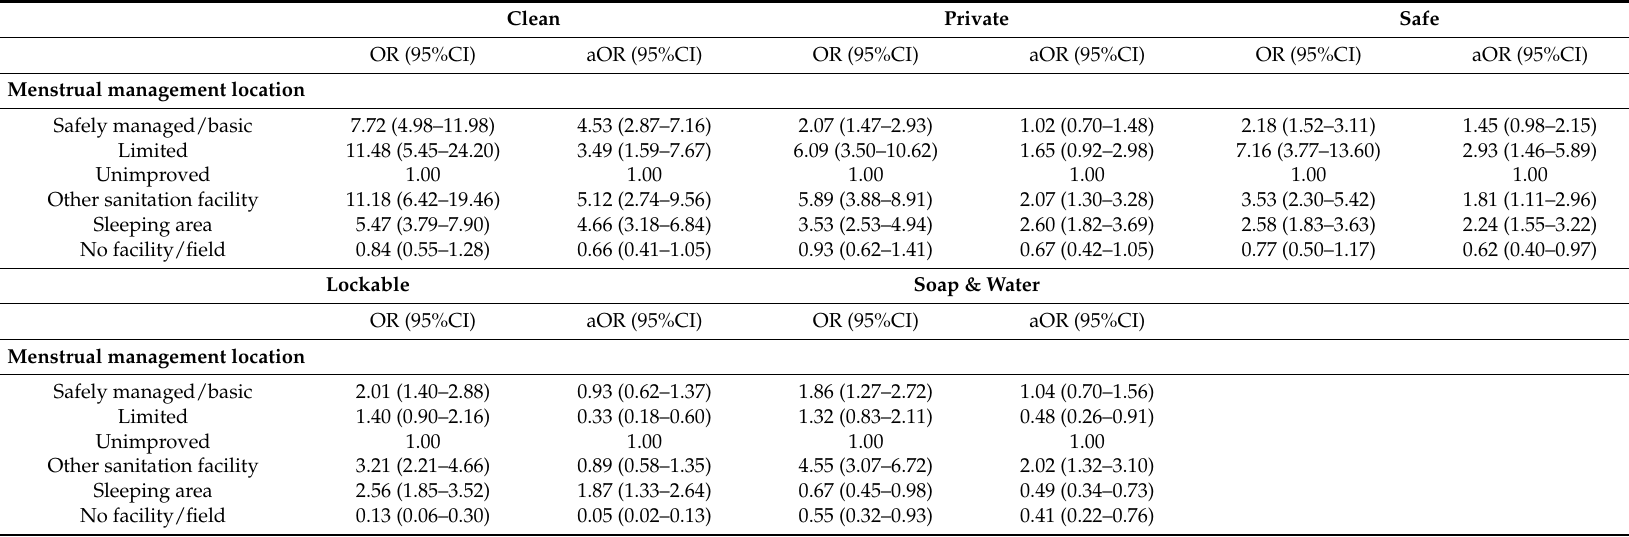
Table 5. Univariate and multivariable relationships between sanitation, hygiene, menstrual materials and sociodemographic characteristics and women’s reports of the characteristics of their menstrual management